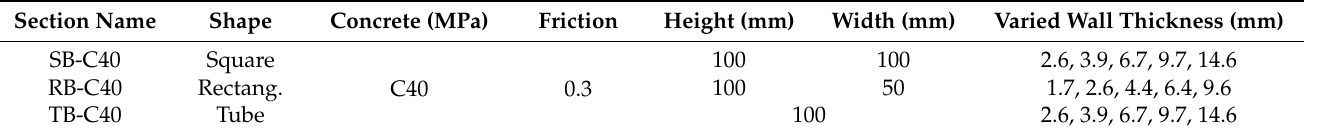
Table 4. Properties of the cross-sections for areal ratios.